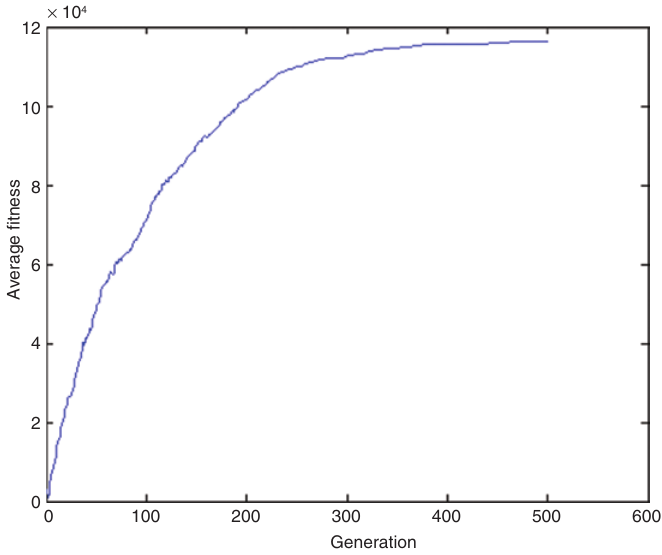
Figure 4. Average Fitness Curve.